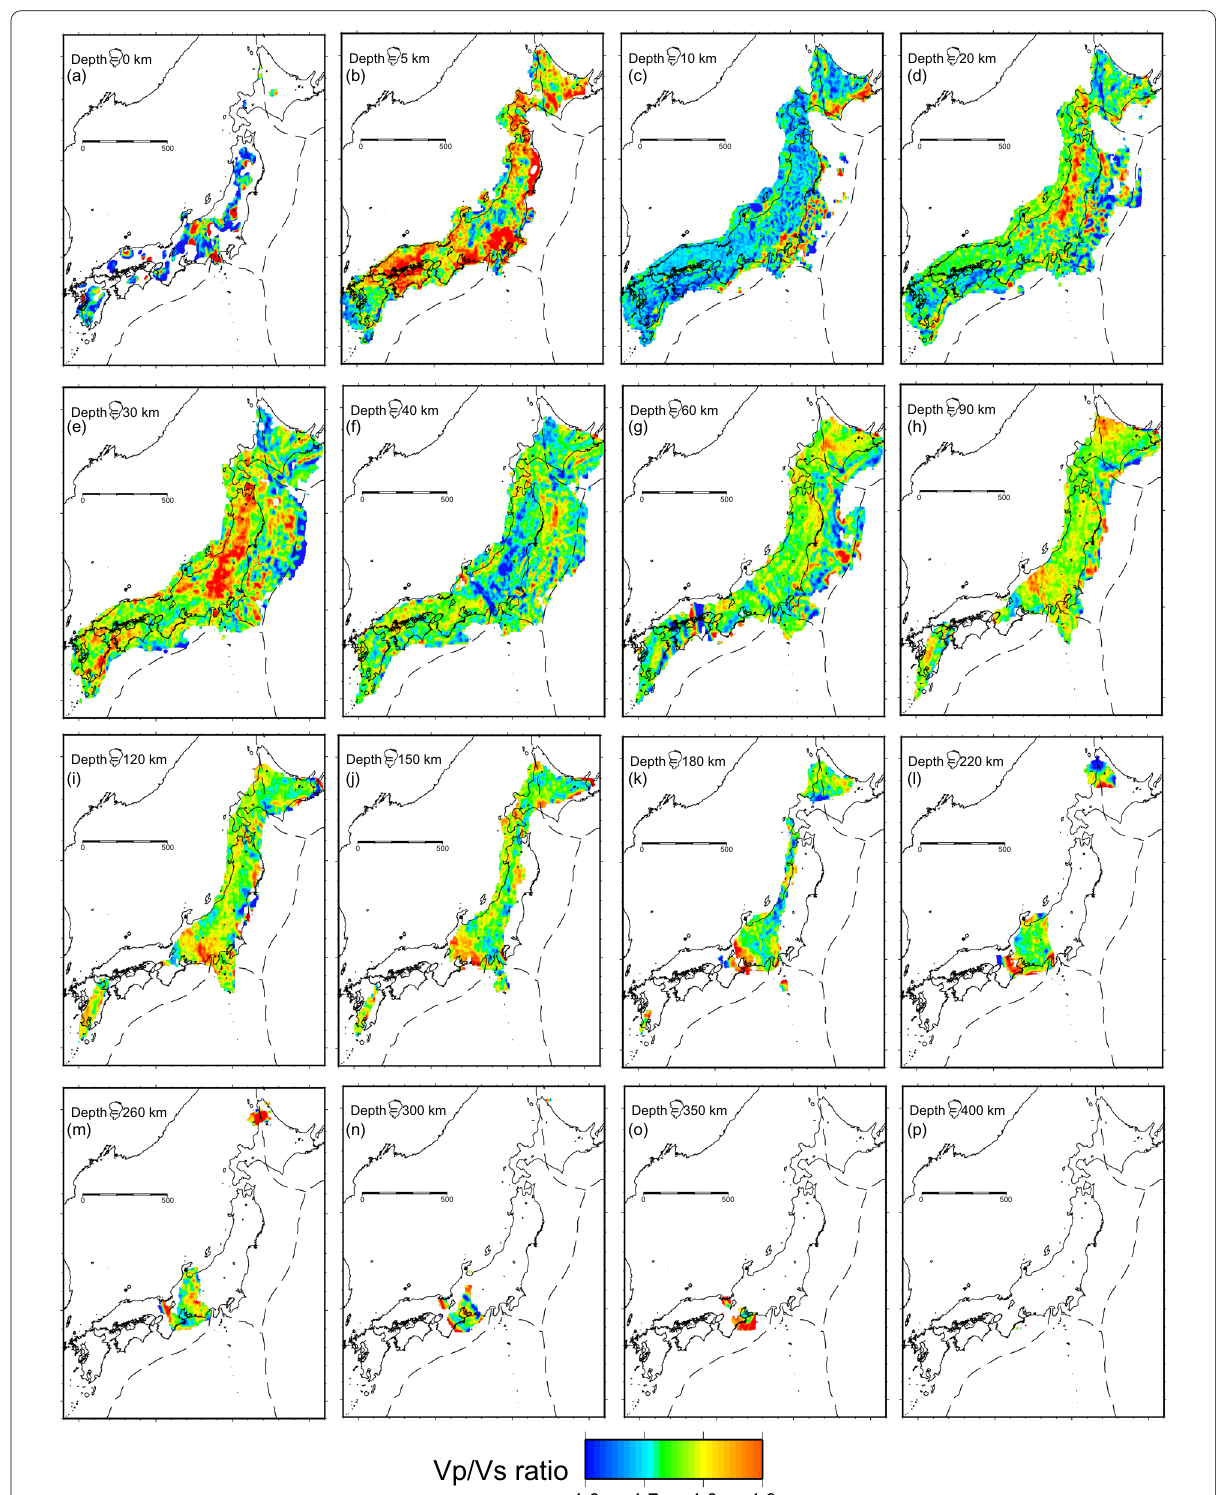
Fig. 12 Map views of Vp/Vs beneath Japanese